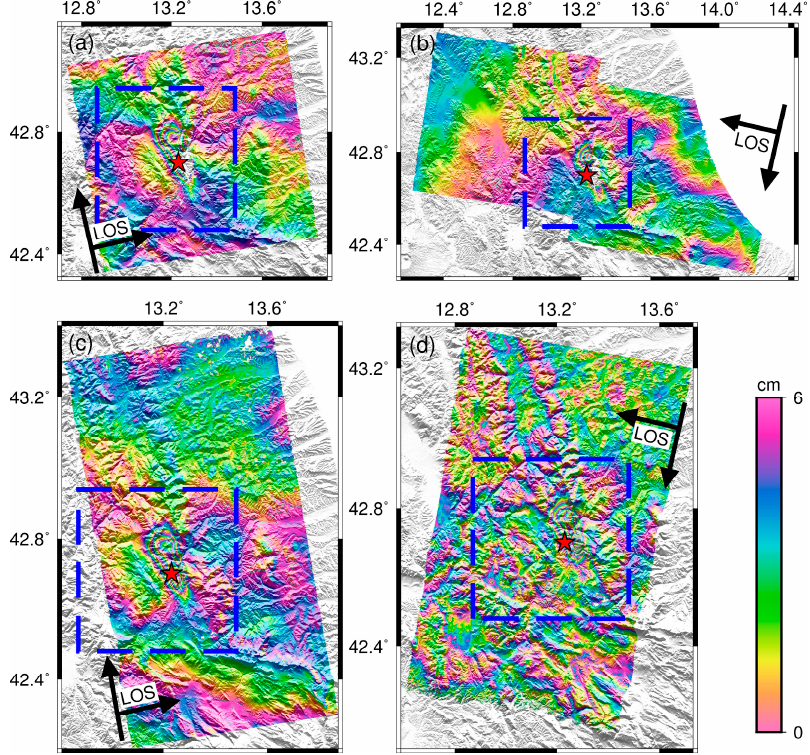
Figure 2. Coseismic interferograms of 24 August 2016 earthquake obtained from the ascending Sentinel-1 track T117 ( a ), the descending Sentinel-1 track T022 ( b ), the ascending ALOS-2 track 197 ( c ), the descending ALOS-2 track 092 ( d ). The red star corresponds to the epicenter of 24 August 2016 Amatrice earthquake [12]. The interferograms are rewrapped with an interval of 6 cm. The blue rectangle outlines the study area.